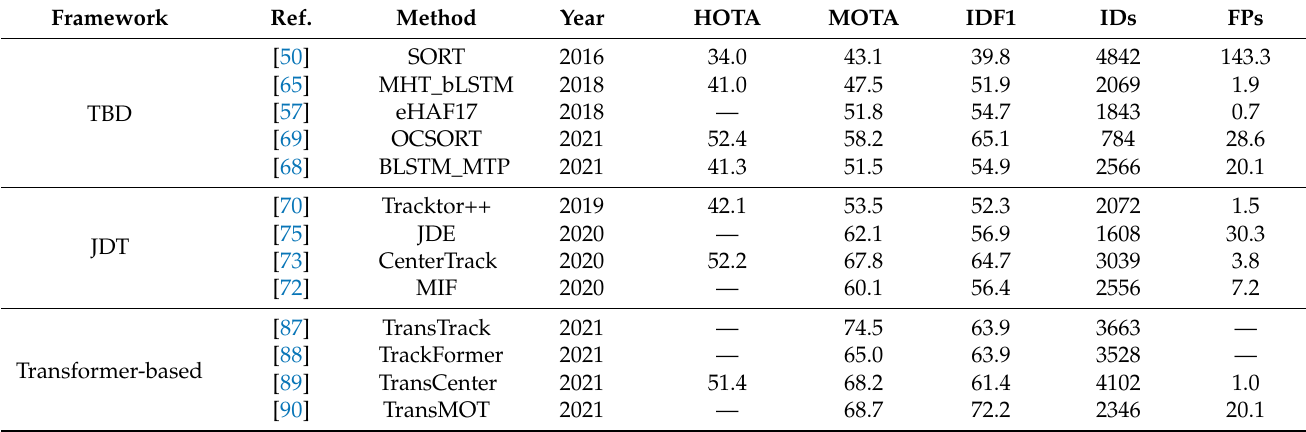
Table 8. In the MOT17 dataset [25], the algorithm evaluation index based on the public detector. Framework Ref.